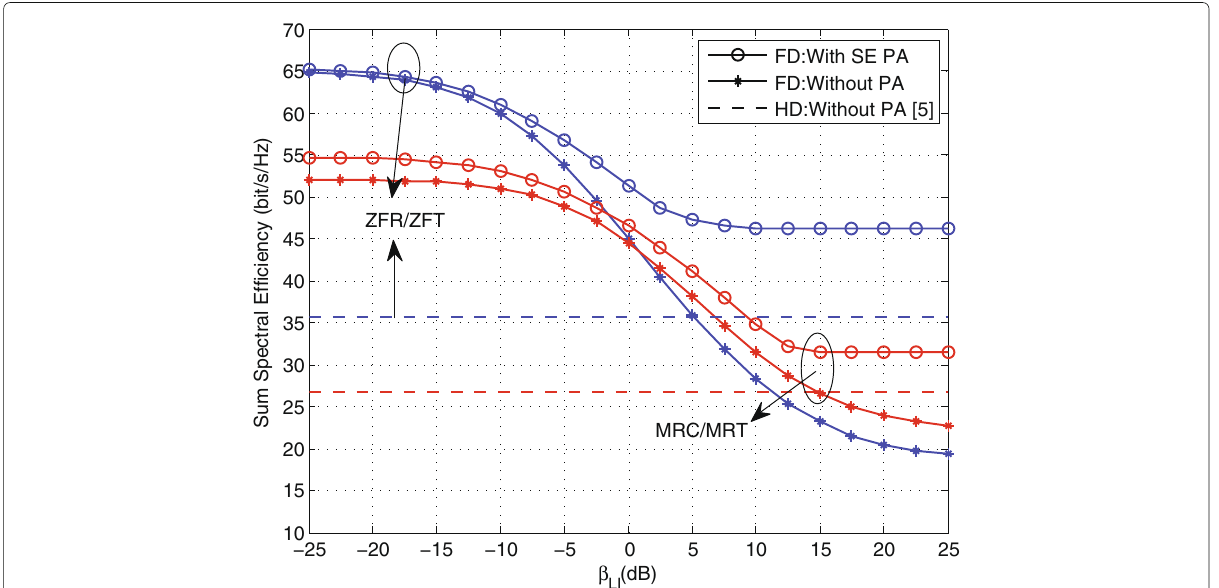
Fig. 6 Comparison of sum SE with and without SE PA versus β LI where p = q = 0.5, P P = 0 dB, N = 200, E U = 10 dB, and E D = KE U strong impact on the SE performance, in which case the PA scheme is particularly